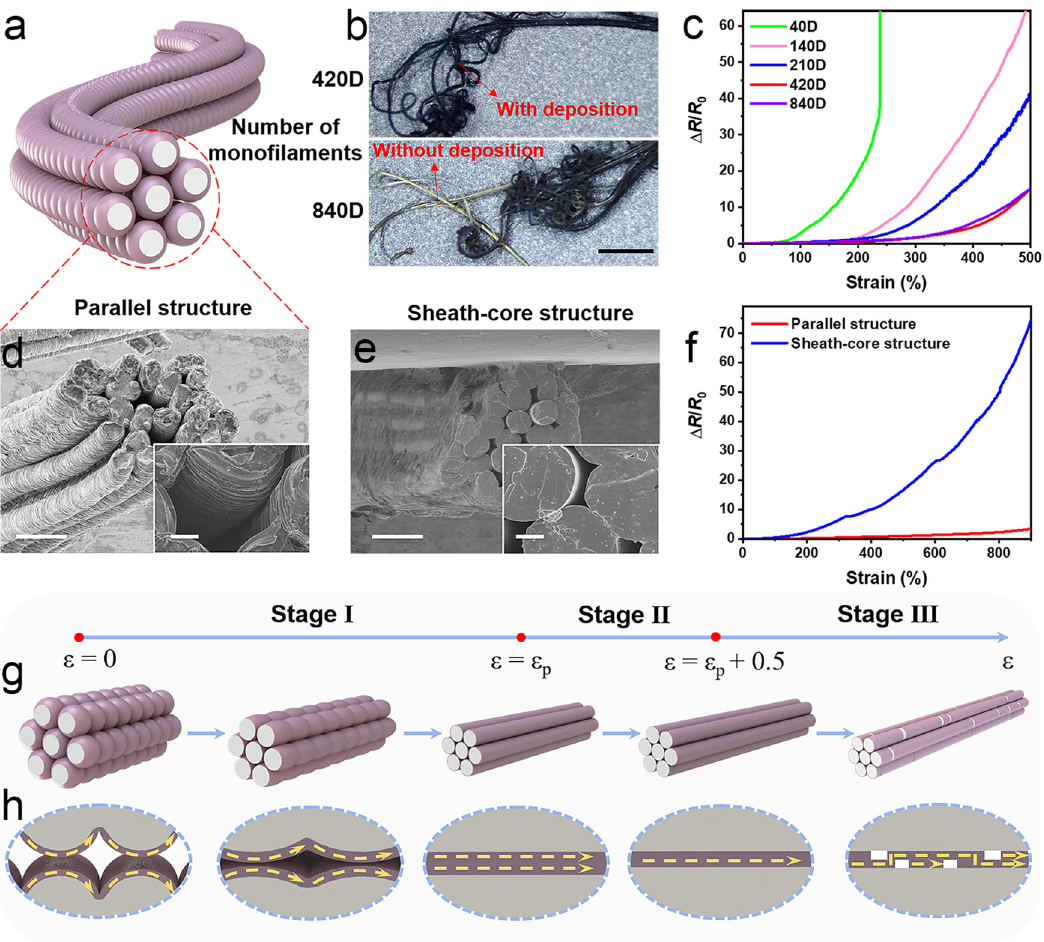
Fig. 3 Effect of the number of parallel conducting mono fi laments on strain-insensitive behavior. a Schematic diagram of parallel @PPy and PU 840D @PPy after breaking. Scale bar is 2 mm. conducting mono fi laments with buckling PPy coating. b Optical photos of PU 420D 50 % 50 % c Relative resistance change of PU x @PPy with different diameters upon increasing strain. SEM images of the cross-section of d PU 420D @PPy 50 % 200 % and e PU 420D @WPU@PPy. Scale bar is: 100 μ m, inset 15 μ m. f Change in relative resistance of the conductive multi fi lament and sheath-core 200 % fi lament under stretching. g Working mechanism of the parallel conductive multi fi lament under increasing strain. h Current path (yellow arrow) along the multi fi lament during